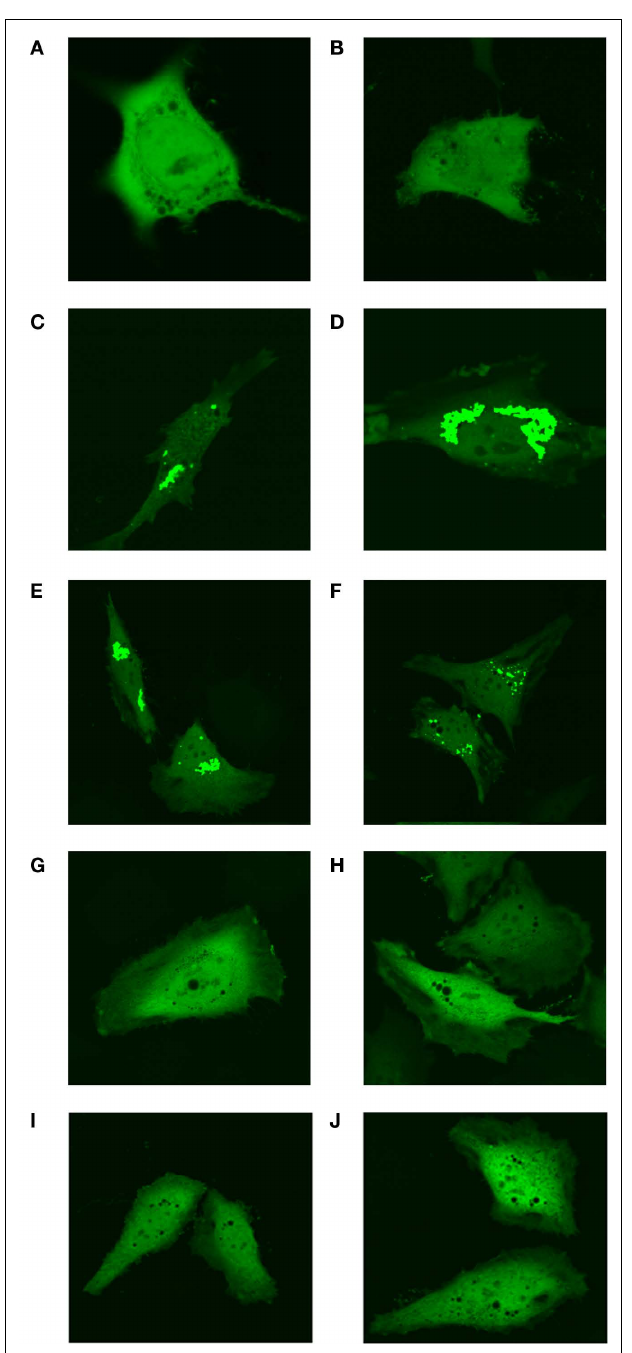
FIGURE 12 | Formation of punctuate “purinosome” clusters is abolished by addition of adenosine and guanosine to media. The MTHFS-GFP protein was expressed in HeLa cells and visualized by confocal microscopy as described in Section “Materials and methods.” Cells were cultured with either purine-rich α -MEM (A, B) , purine-depleted RPMI-1640 (C, D) , or purine-depleted RPMI-1640 supplemented with individual nucleosides.The nucleosides were added at 10mg/L, the concentration at which they are present in the purine-rich α -MEM. Pyrimidine nucleosides uridine and cytosine were added together (E, F) . Purine nucleosides adenosine (G, H) and guanosine (I, J) were added individually.